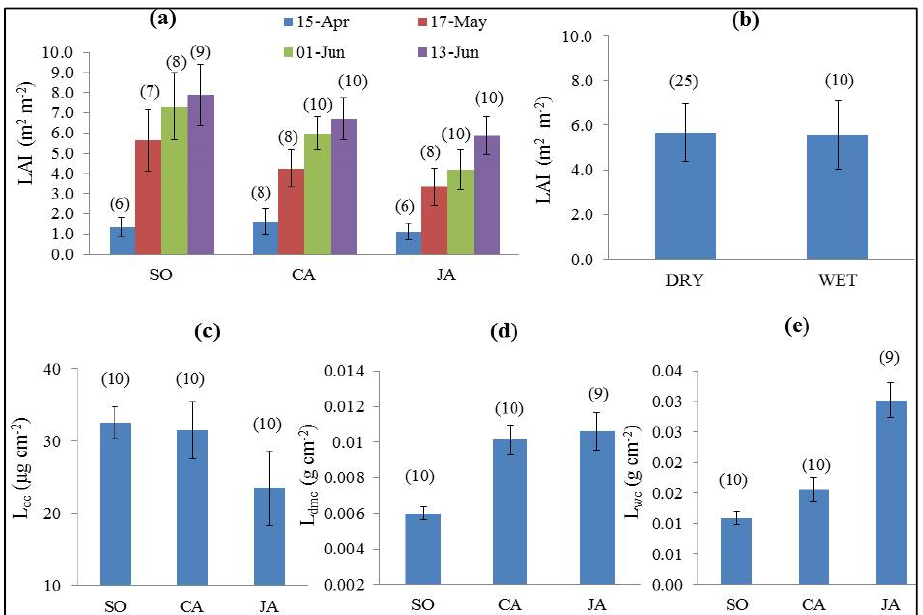
Figure 5 . ( a – e ) Field measurements for ( a ) LAI , ( c ) leaf chlorophyll content; ( d ) leaf dry matter content; ( e ) leaf water thickness for SO , CA and JA (measured on 13 June 2014) and ( b ) LAI measurements for DRY and WET class (measured on 5 and 9 July 2013). The values in the brackets show the number of sampling locations ( a , b ) and number of samples ( c – e ).